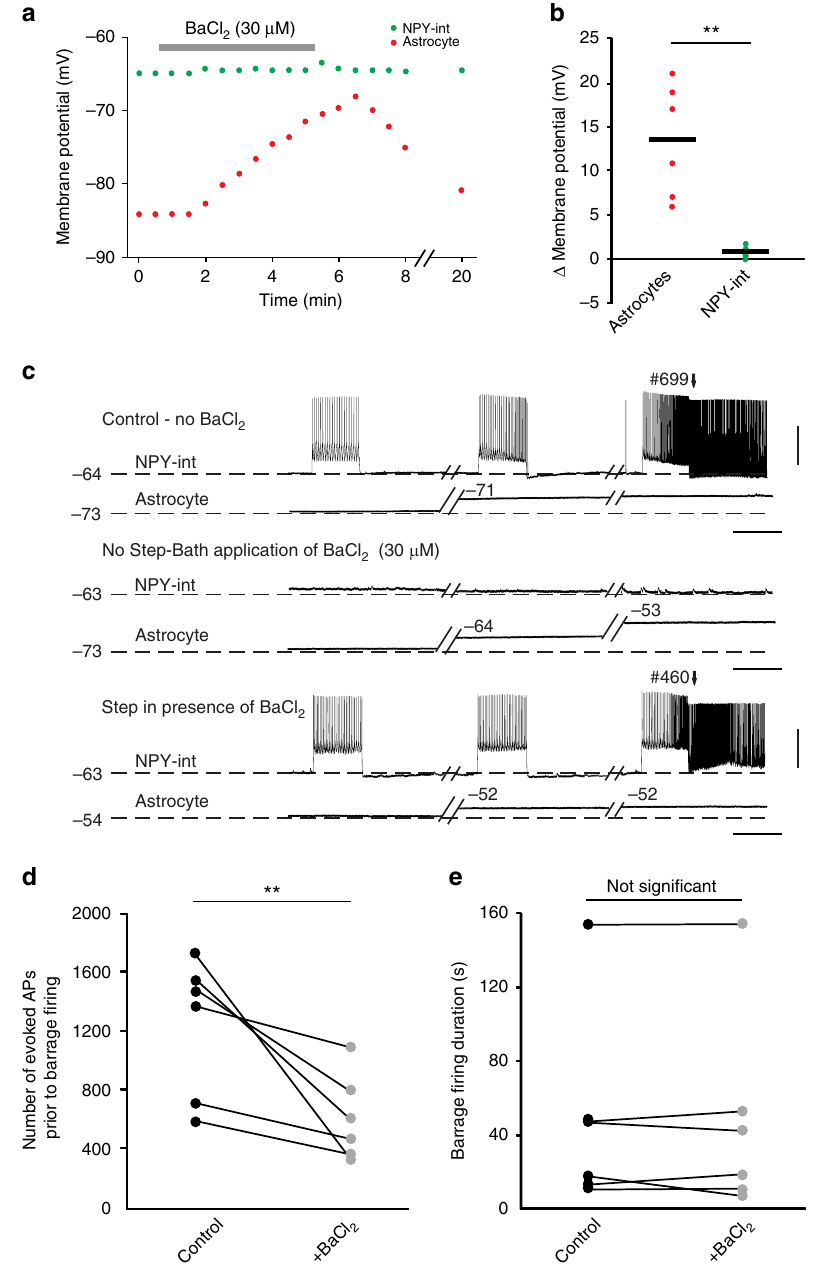
Fig. 2 Depolarizing astrocytes enhances induction of barrage fi ring. a Effect of bath application of 30 µ M BaCl 2 on the membrane potential of an NPY interneuron (green) and astrocyte (red) during an example double recording. b Change in membrane potential of NPY interneurons and astrocytes in response to bath application of BaCl 2 for all recordings ( n = 6 double recordings from 3 mice; paired t test, ** p = 0.01). c Example recording showing the effect of BaCl 2 on astrocyte depolarization, which results in earlier barrage fi ring generation. Scale bars, 35 mV, 1 s. d BaCl 2 application resulted in a decrease in the number of action potentials required for barrage fi ring induction ( n = 6; paired t test, ** p = 0.002). e BaCl 2 application did not affect the duration of barrage fi ring ( n = 6). Data are represented as mean ±